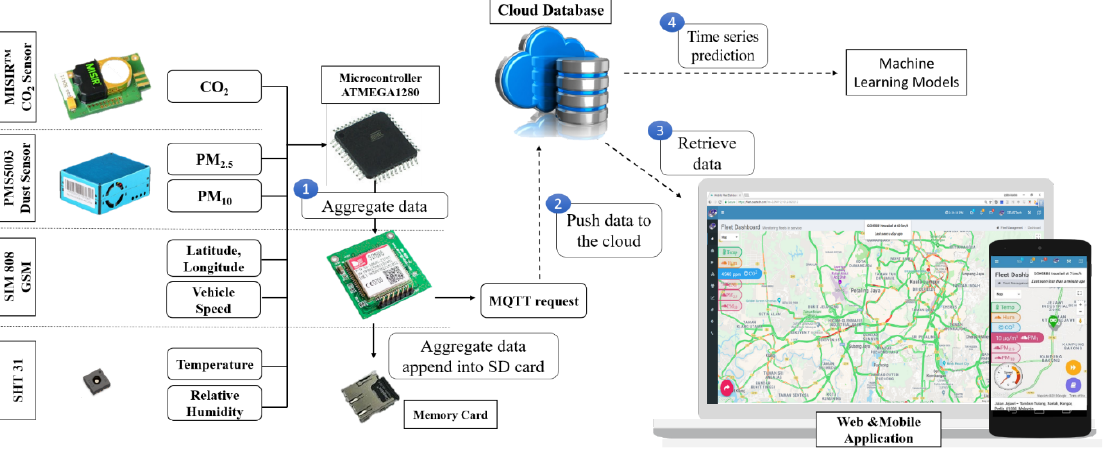
Figure 1. Overall System Design for Air Quality Prediction.